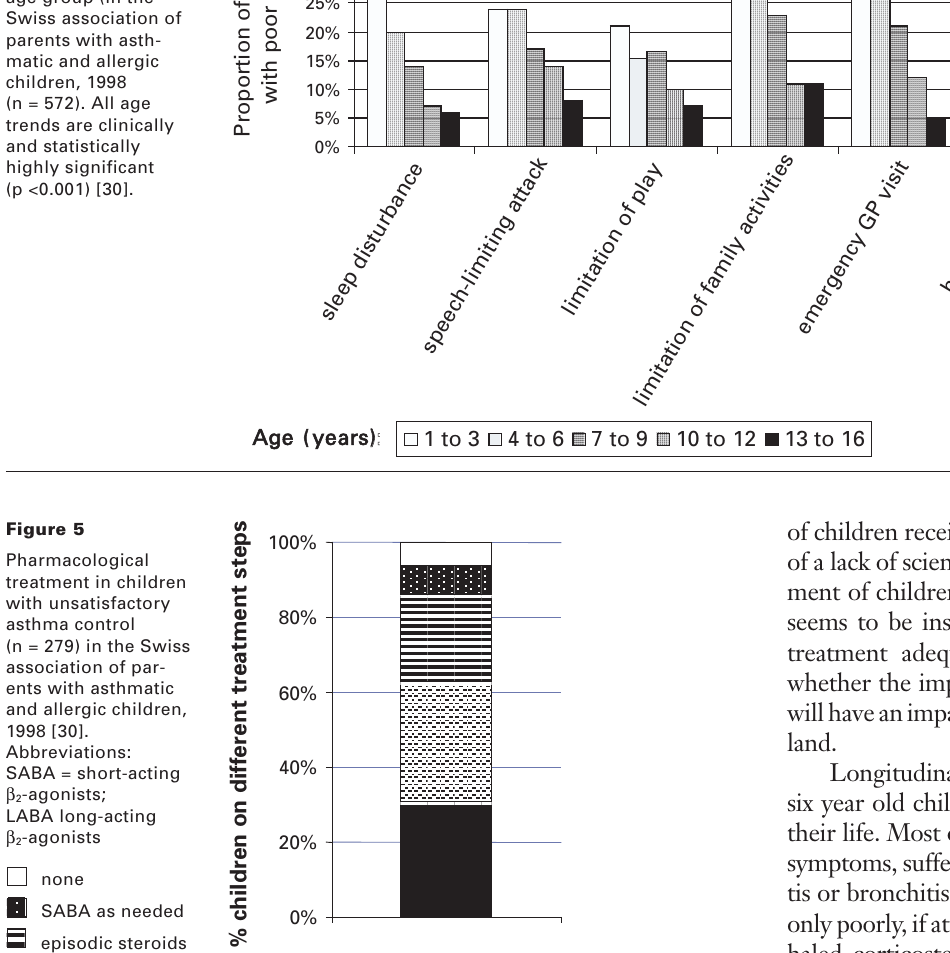
Proportion of current wheezers with poor symptom control by age group (in the Swiss association of parents with asth- matic and allergic children, 1998 (n = 572). All age trends are clinically and statistically highly